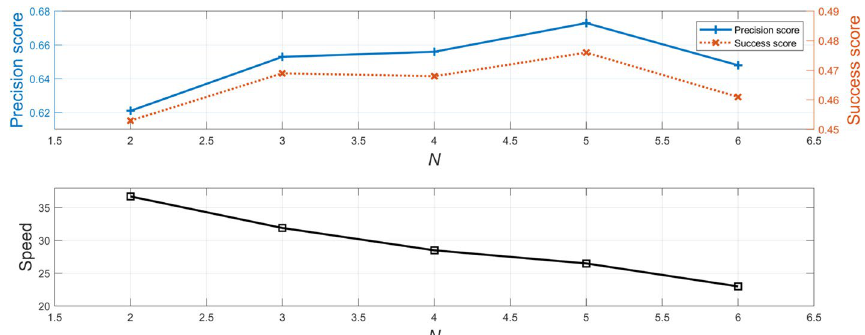
Fig. 12 Tracking performance of precision score, success score, and speed on the UAV123@10fps dataset with different numbers of ADMM iterations